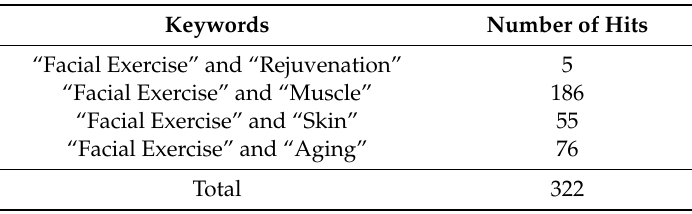
Table 1. Combinations of keywords and number of hits in